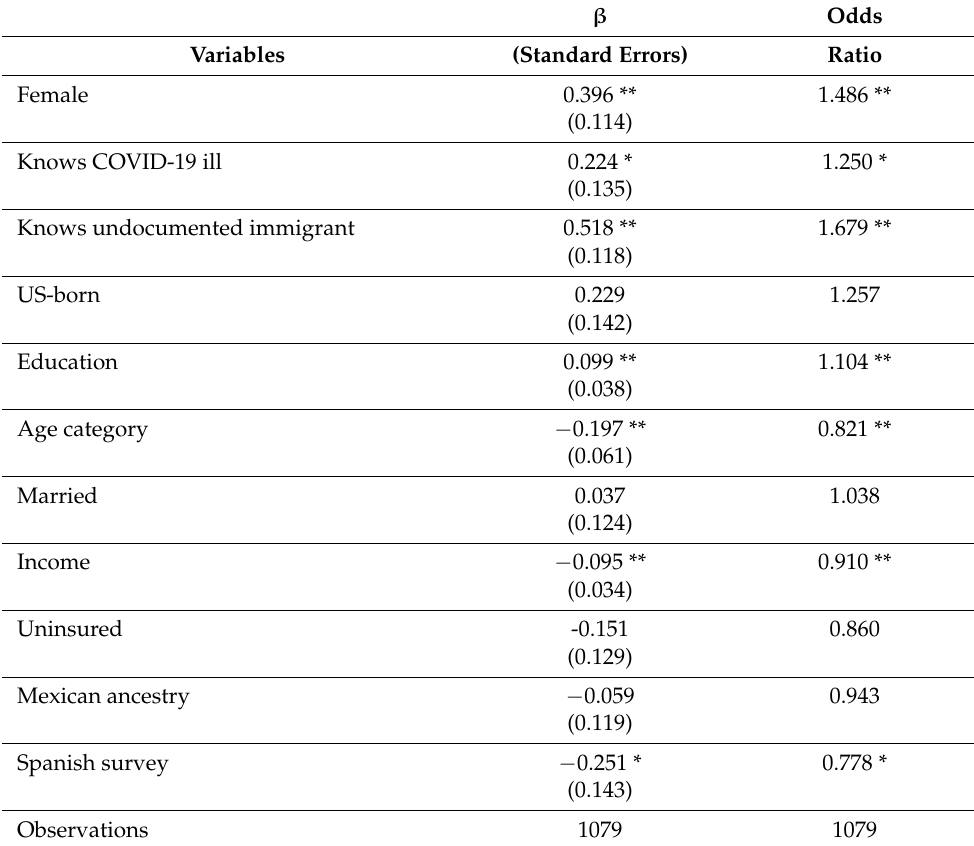
Table 2. Effect of gender and personal experiences on mental health during COVID-19